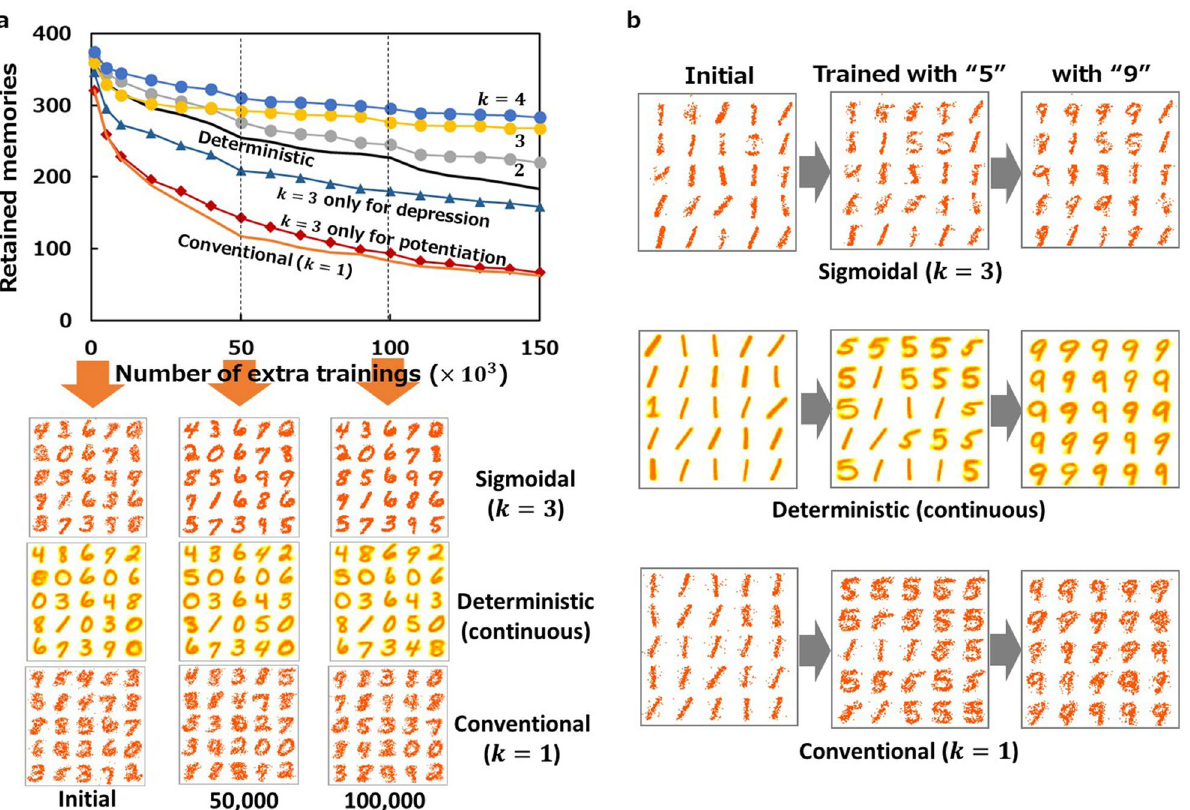
q = 0.03 ) and k = 4 (with p = 0.2 and q = 0.08 ). For comparison, those obtained with conventional ( k = 1 ) with the conventional rule with q = 0.008 ), and in the opposite case (with p = 0.04 and q = 0.03 ) are also plotted. Colour intensity maps of synaptic weights afferent to 5 × 5 = 25 excitatory neurons out of 400 in the second layer are shown after the initial training and 50,000 and 100,000 additional trainings. Each pixel in the map correspond to a weight. Thus, each panel contains 28 × 28 × 25 = 19, 600 pixels. White and red indicate 0 and 1, respectively. The intermediate values for continuous weights are represented by yellowish colours. (b) Colour intensity maps showing the results of the benchmark test of memory maintenance (described in the